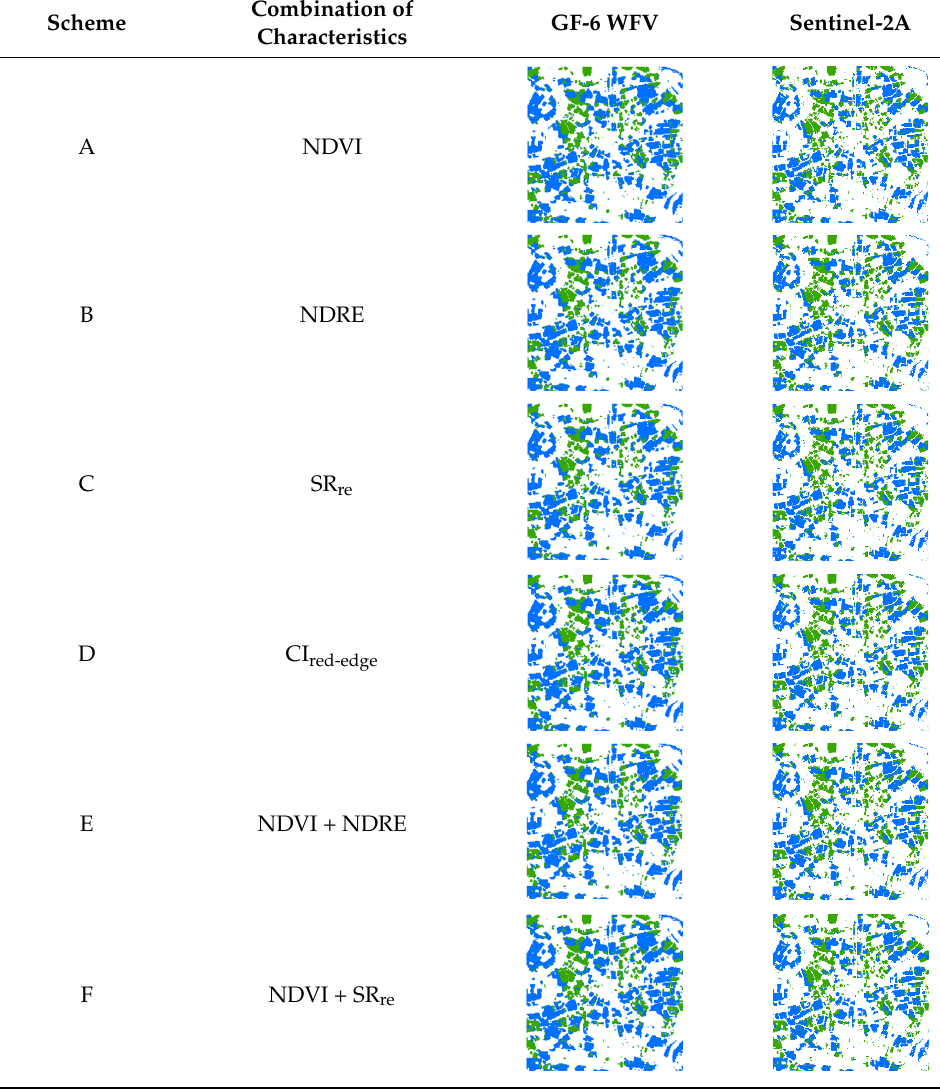
Table 10. Sensitivity comparison of vegetation index combination schemes for GF-6 WFV and Sentinel-2A data. Scheme